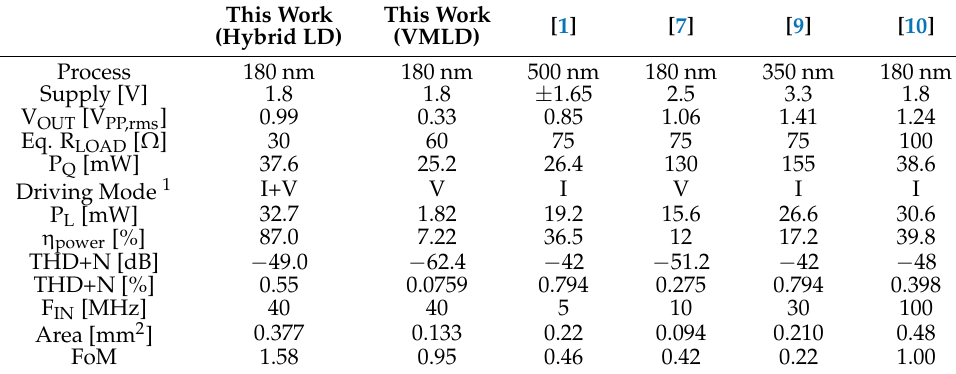
Table 2. Proposed Line Driver’s Performance Comparison with Prior